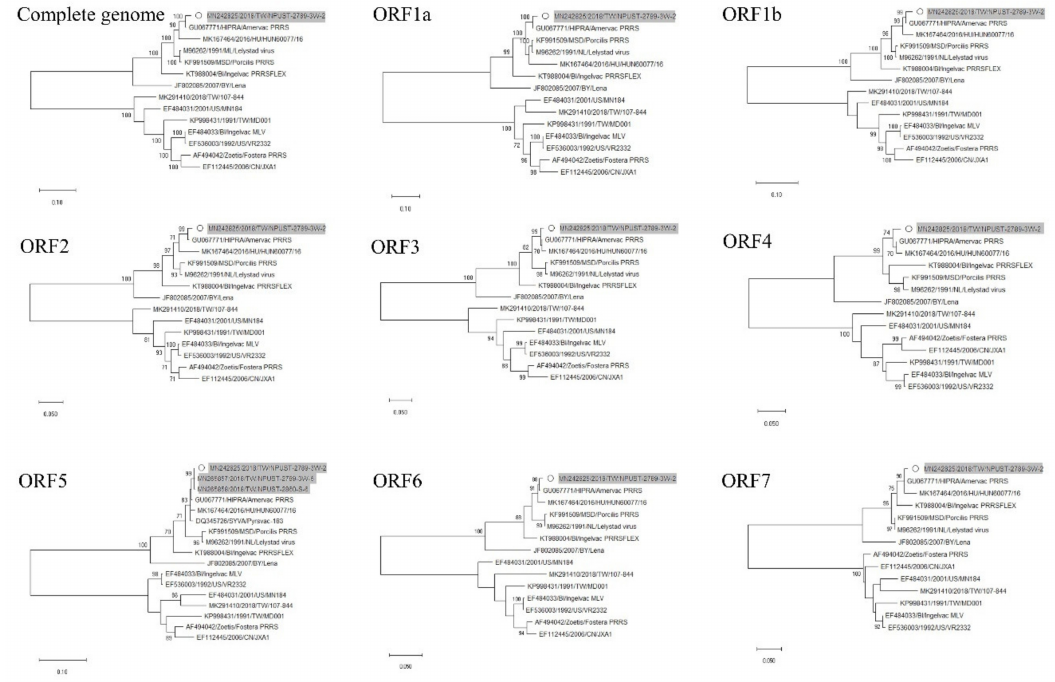
Figure 4. Phylogenetic relationships constructed using complete genomes, ORF1a, ORF1b, ORF2, ORF3, ORF4, ORF5, ORF6 and ORF7 gene sequences of PRRSV / NPUST-2789-3W-2 / TW / 2018 (NPUST2789) and other PRRSVs. The phylogenetic tree was constructed using the maximum likelihood method with bootstrap analysis ( n = 1000) to evaluate clade confidence. Bootstrap support values greater than 70 are shown. The circle represents the PRRSV strain NPUST2789. The gray underlay represents local PRRSV 1 strains isolated in the present